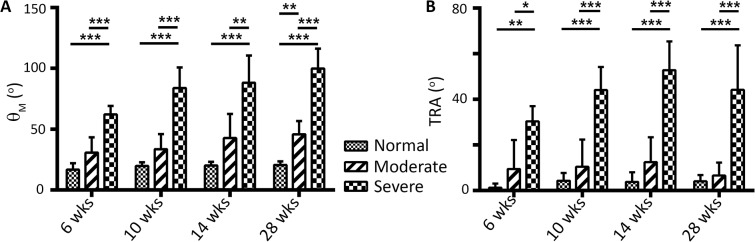
Deformity.(A) Maximal overall spine deformity, θM, in each group at all time points and (B) TRA in each group for all time points are shown. Bonferroni statistical significance is indicated: *p<0.05; **p<0.01; ***p<0.001.